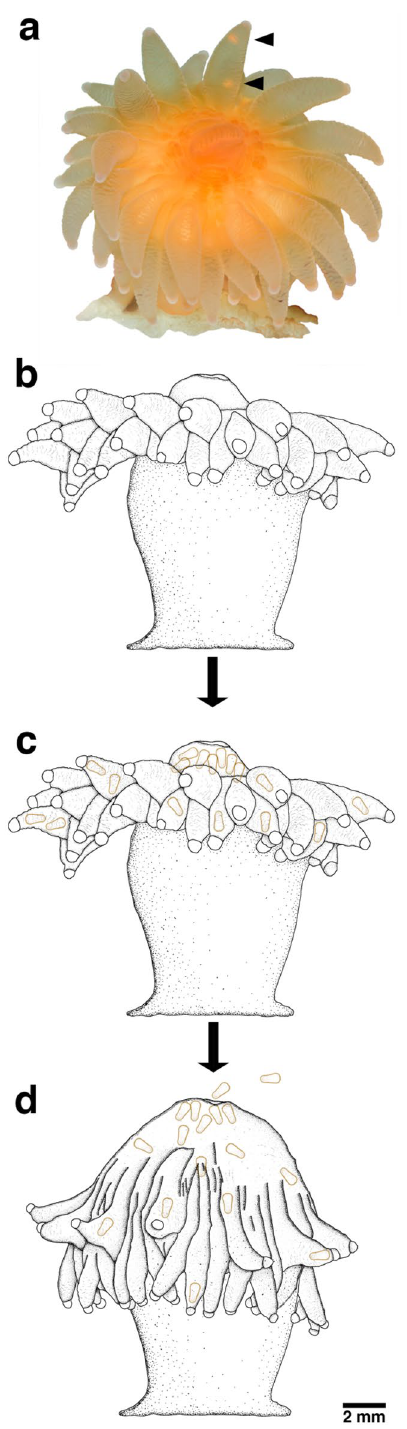
Figure 1. Temporal sequence of larval release of Caryophyllia huinayensis. ( a ) reproductive polyp with two larvae (black arrowheads) in a tentacle. Schematic drawing of ( b ) a polyp with larvae not visible or absent, ( c ) polyp with larvae in the gastrovascular cavity and tentacles, and ( d ) forming the dome shape before releasing larvae (in orange) through the